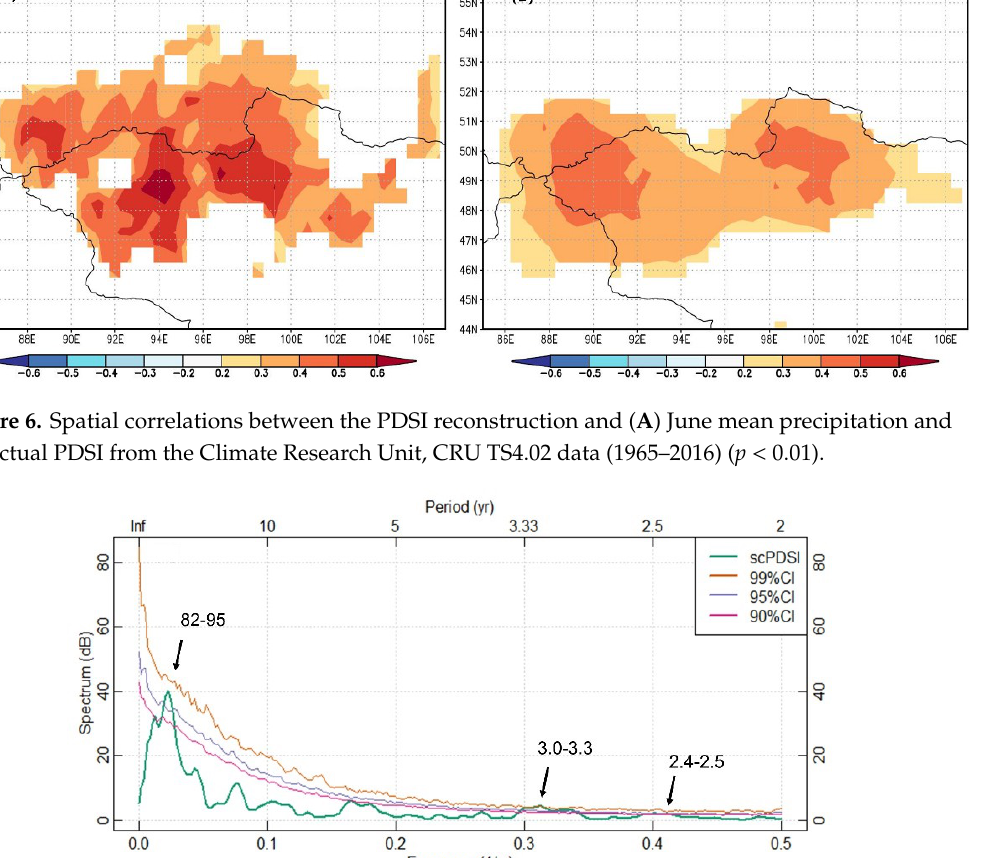
Figure 7. Results of the multi-taper method (MTM) spectral analysis of the temperature reconstruction.